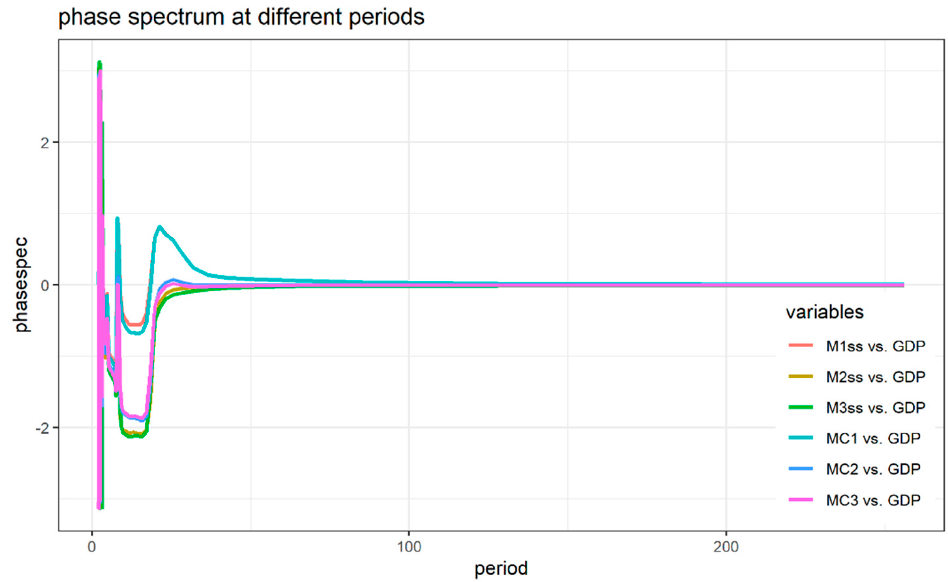
Figure 9. Phase differences with all periods.